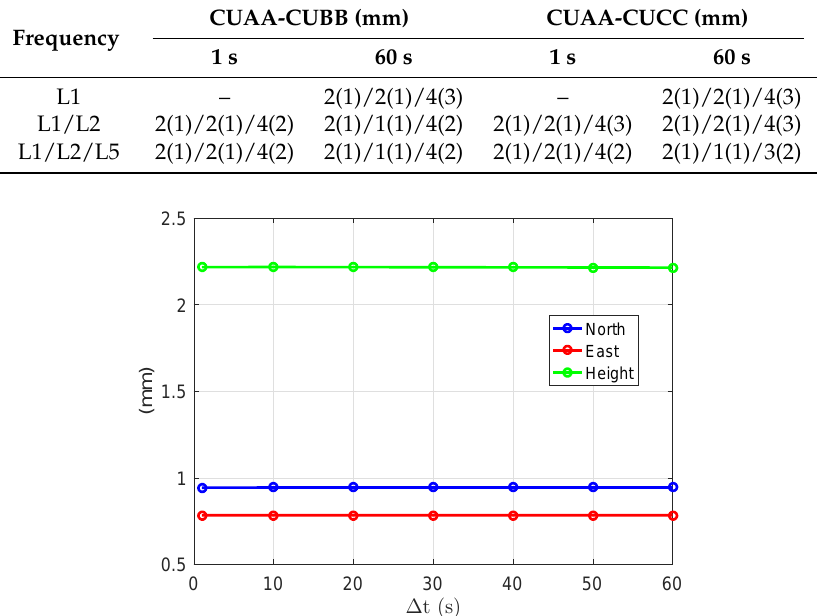
Figure 16. Average formal standard deviations of the baseline errors in the ambiguity-fixed case. GPS triple-frequency phase data of baseline CUAA-CUBB was used for the